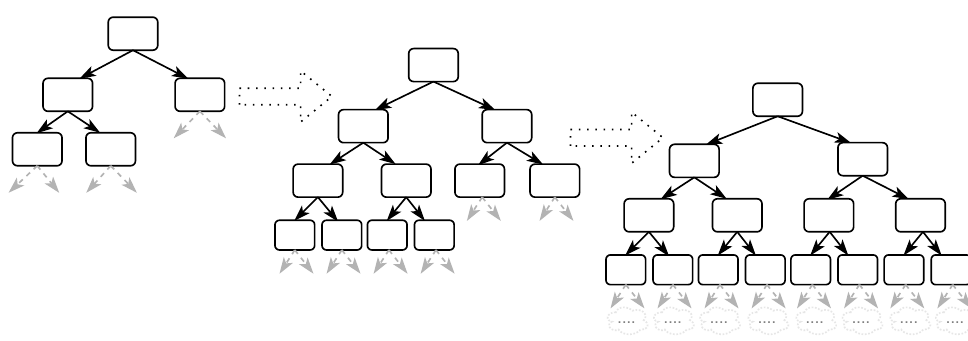
Figure 3. Construction of concolic execution tree.